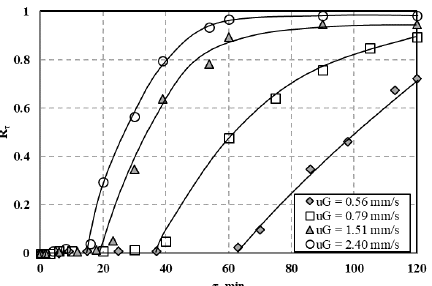
Figure A21. Changes in Zn(II) temporary removal ratio during ion flotation from solution con- taining Al(III), Cu(II) and Zn(II) mixture—effect of air velocity (c 0 = 0.15 mmol dm − 3 , pH = 3.0, c SDS = 1.186 mmol dm − 3 ).